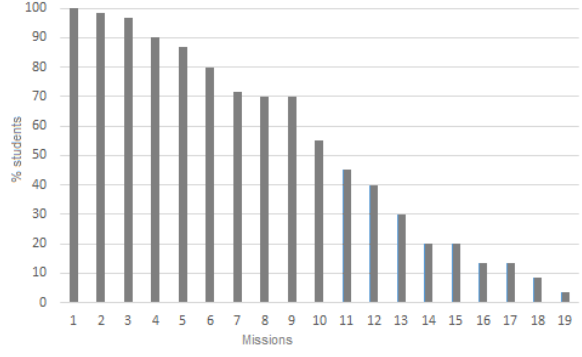
Figure 6. Distribution of the missions finished by students.